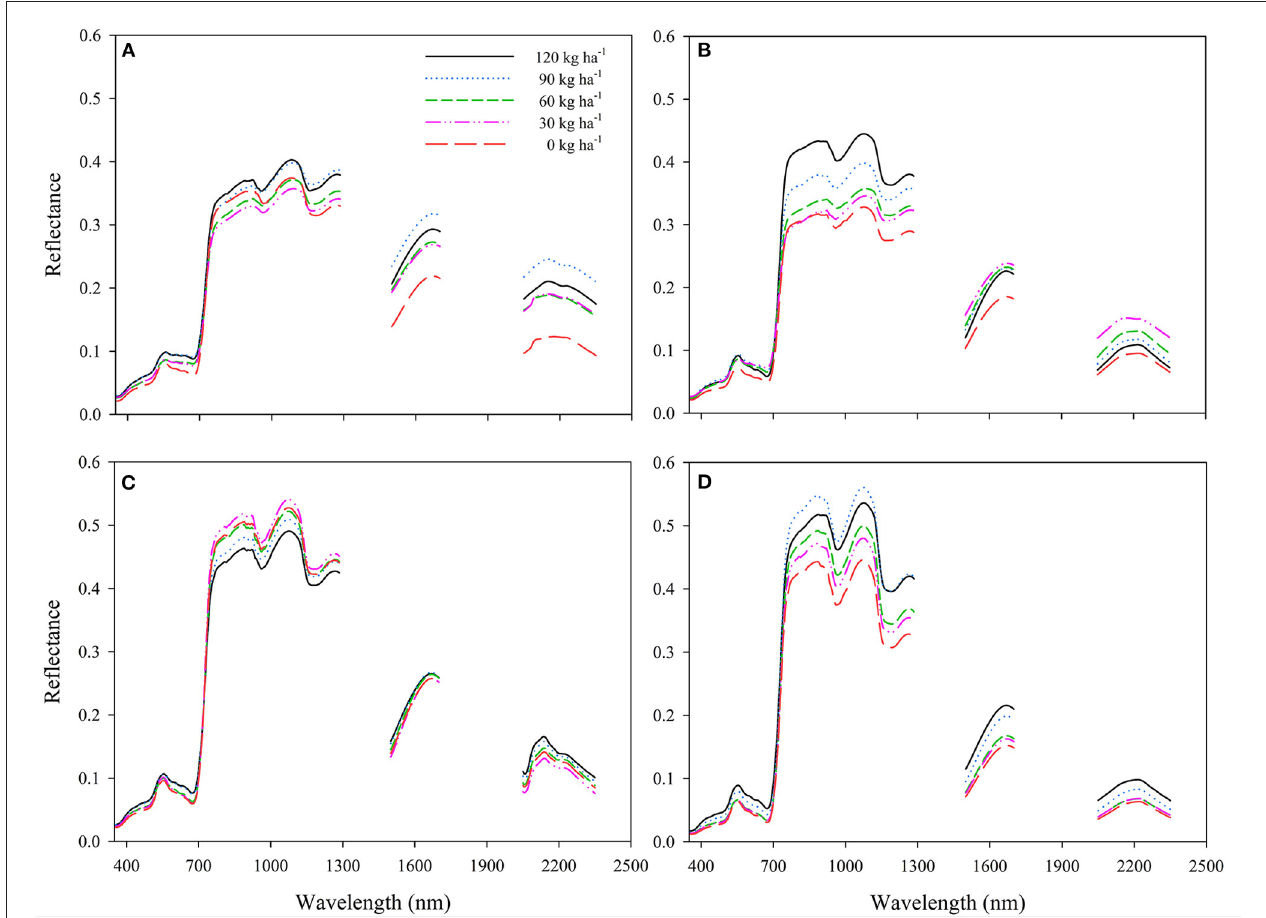
FIGURE 2 | Mean canopy reflectance of finger millet under five nitrogen fertilizer rates when sampled at (A) 38, (B) 46, (C) 52, and (D) 76 days after